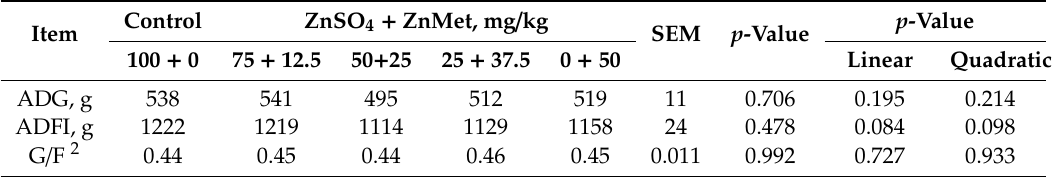
Table 2. E ff ects of dietary substitution of zinc sulfate (ZnSO 4 ) by low levels of zinc methionine (ZnMet) on growth performance of 37- to -79-d-old piglets 1 .